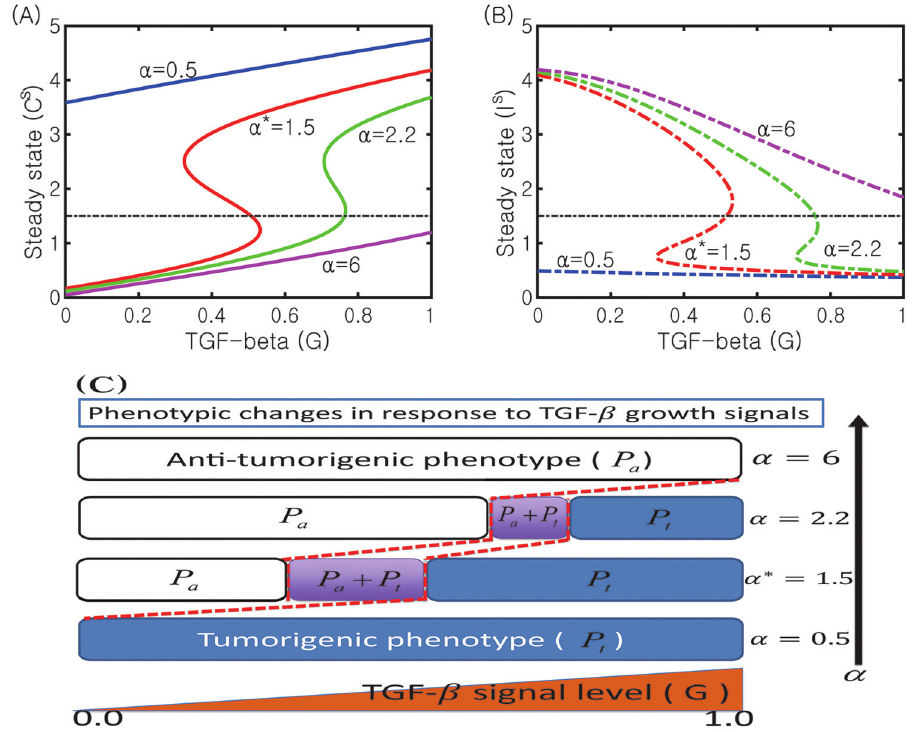
Fig 9. Transition to the N1-dominant environment by increasing α . (A, B) Bifurcation curves G − C ( C s in (A)) and G − I ( I s in (B)) for various N2 inhibition strengths ( α = 0.5, 1.5, 2.2, 6.0). (C) The corresponding phenotypic switches between tumorigenic and anti-tumorigenic phases when α is varied. Other parameters are fixed as in Table 2. The base case ( α � = 1.5) was marked in star ( �